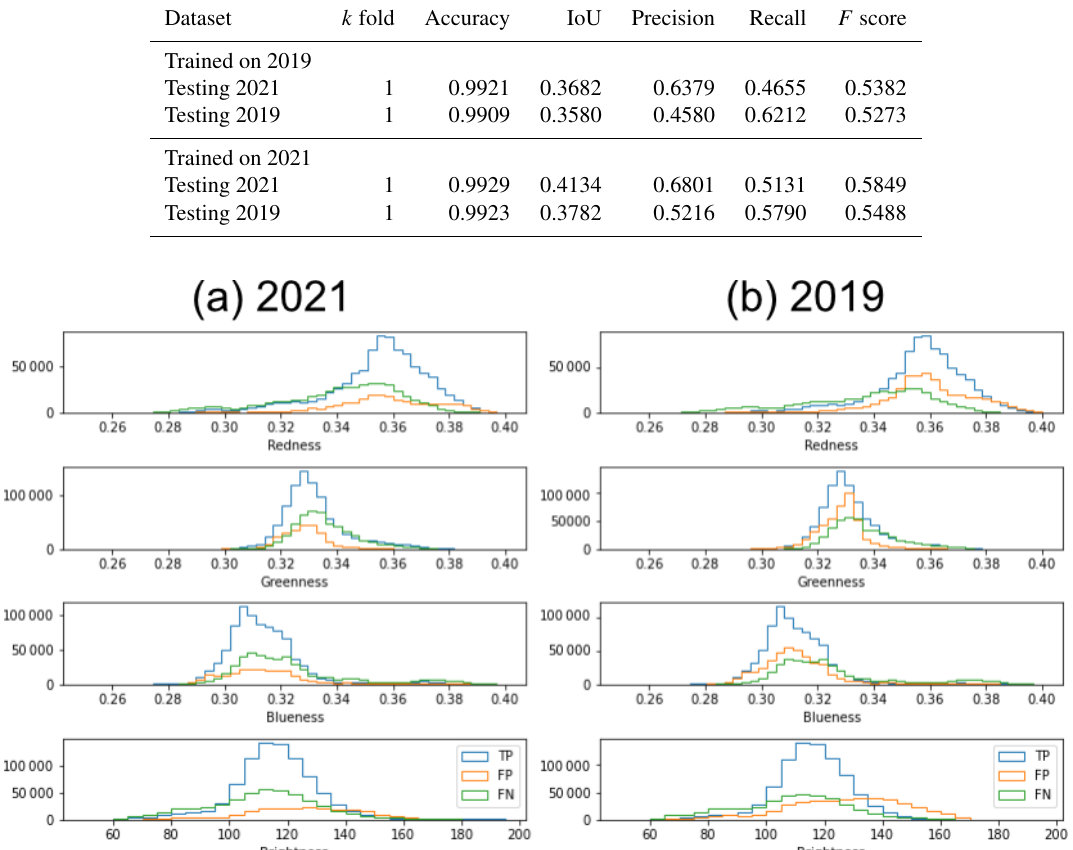
Figure 6. Colour and brightness of pixels in false positive (FP), true positive (TP), and false negative (FN) groups for (a) 2021 imagery and labels and (b) 2019 imagery and labels. The model was trained on 2021 imagery and labels.